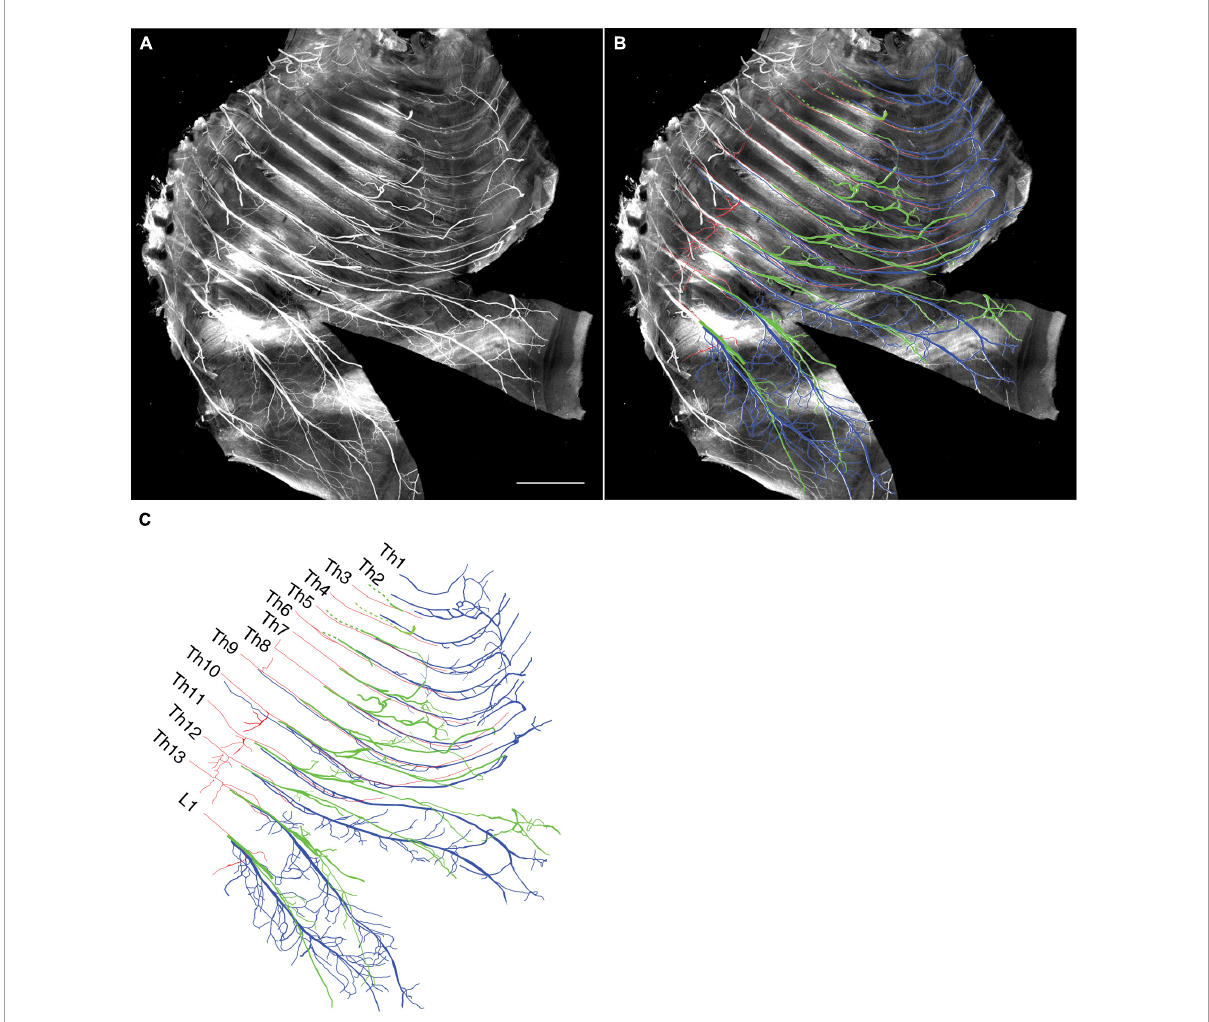
FIGURE4 Branching pattern of the intercostal nerve from a mouse embryo on E15. All micrographs are in the surface view of the unilateral side of the thoracic wall from an E15 embryo. The dorsal side is toward the left of the micrographs. The anterior side is toward the top of the micrographs. Because of the pronounced curvature of the thoracic wall, the two split lines are in the lower portion of the wall for mounting. (A) MIP image. (B,C) Tracing of the branches. The deep branch is in blue, the superficial branch is in red, and the lateral cutaneous branch is in